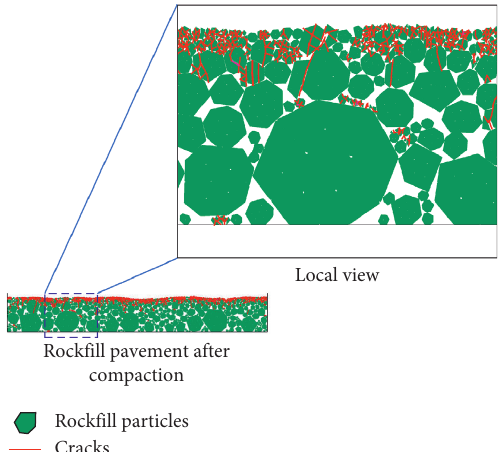
Figure 15: Distribution of cracks in the rockfill